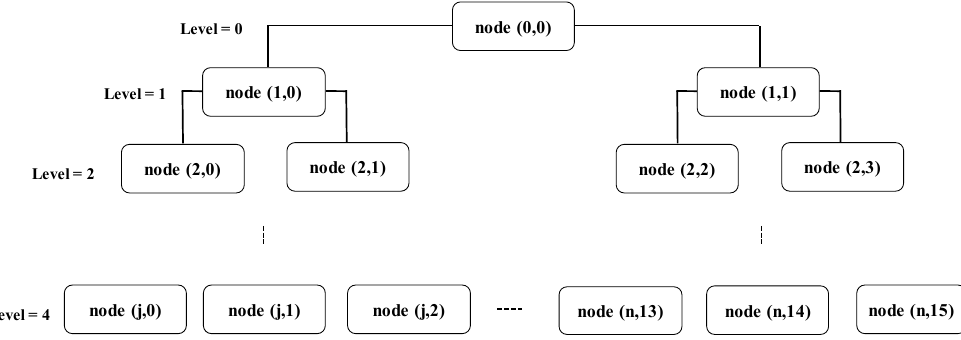
Figure 2. A 4-level wavelet packet tree having 2 4 nodes .